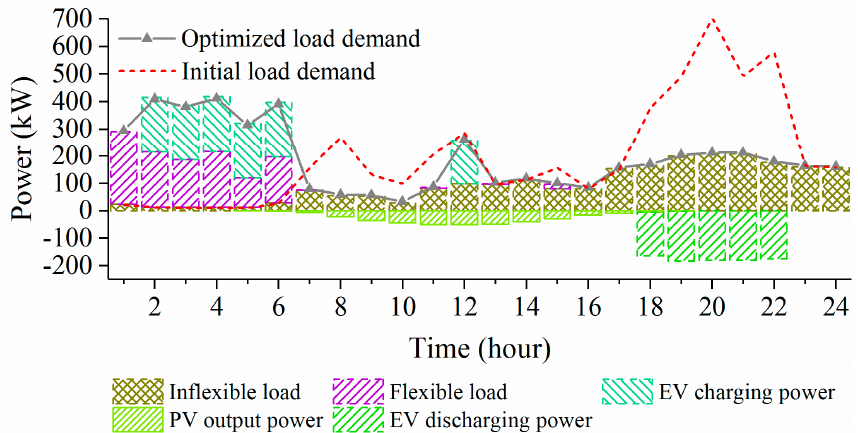
Figure 9. Appl. Sci. 2019 , 9 , x FOR PEER REVIEW